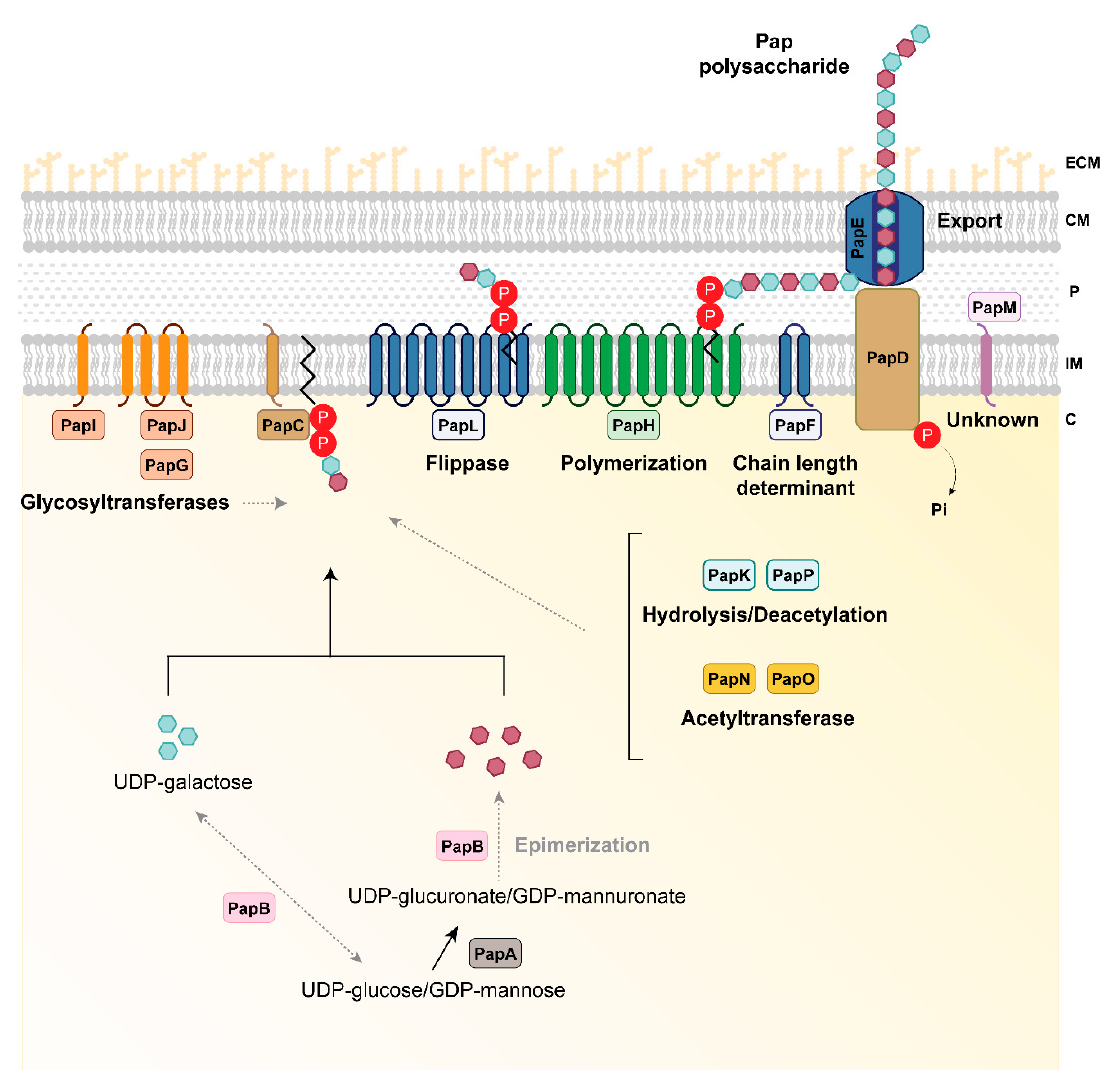
Figure 3. Hypothetical model of P. fluorescens F113 Pap biosynthesis. PapA is a UDP-glucose / GDP-mannose dehydrogenase involved in the generation of the Pap polysaccharide residues (purple hexagons). PapB is predicted to be an epimerase that could be involved in the modification of the residues formed by PapA or providing the pool of sugar precursors for the synthesis of Pap. PapC is a phosphotransferase putatively involved in the phosphorylation of UDP-galactose in the synthesis of polysaccharide residues (blue hexagons) and the link of the sugar chain to a lipid carrier in the inner membrane. Once the constituting residues are synthesized, Pap is subjected to several modifications via glycosyltransferases (the cytoplasmic PapG and the inner membrane proteins PapI and PapJ), acetyltransferases (the cytoplasmic PapN and PapO), as well as deacetylation by the cytoplasmic PapK and PapP proteins to ultimately form the mature polysaccharide. The polymerization process and flippase machinery could be carried out by the inner membrane proteins PapH and PapL, respectively. The length of the synthesized polysaccharide could be controlled by the PapF inner membrane protein. The polysaccharide is exported to the milieu via the inner membrane tyrosine-kinase PapD and the outer membrane protein PapE. Whether the polysaccharide is secreted or remains attached to the cell-surface is unknown. There are additional proteins with unknown and no-predicted functions in the biosynthetic process such as PapM. Proteins are colored according to their predicted function as shown in Figure 1. Black solid lines indicate the steps catalyzed by each enzyme. Grey dashed lines indicate putative links or steps that need to be further investigated. C, cytoplasm; ECM, extracellular matrix; IM, inner membrane; P, periplasmic space; OM, outer membrane; P inside a red circle represents